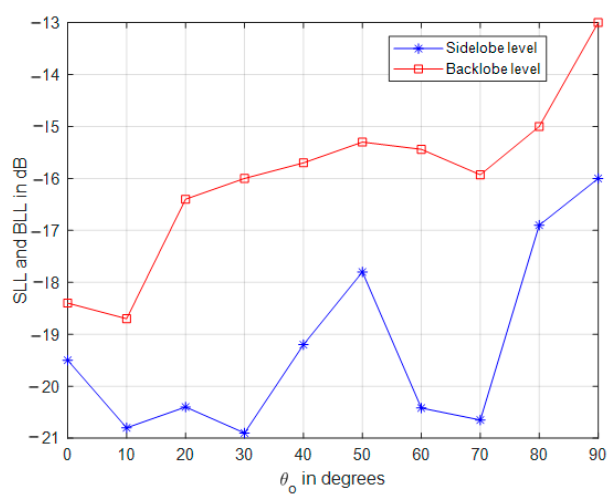
Figure 10. Sidelobe and backlobe variation with the mainlobe direction.